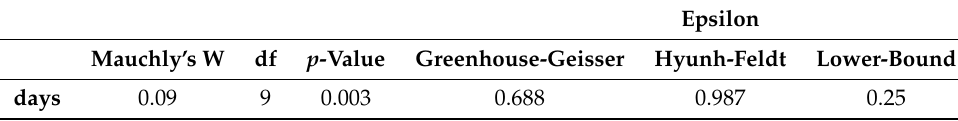
Table 1. Mauchly’s test of sphericity. Within subjects